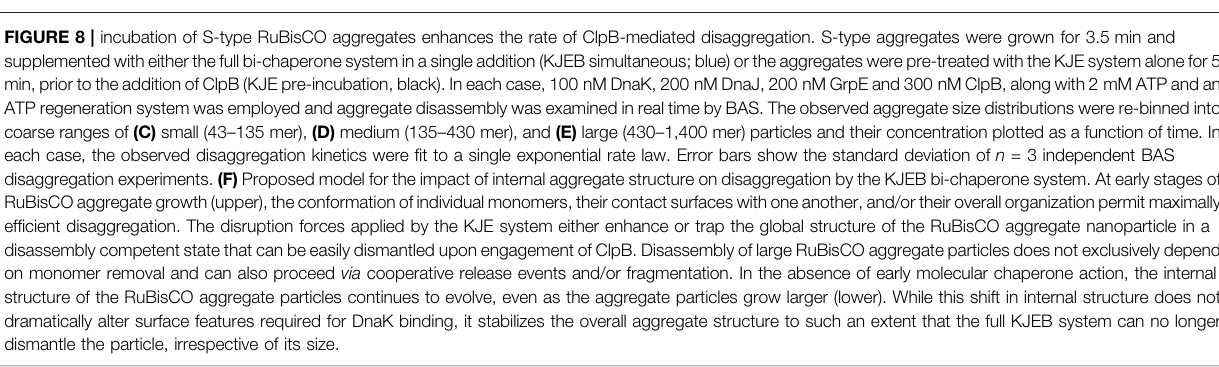
FIGURE 8 | incubation of S-type RuBisCO aggregates enhances the rate of ClpB-mediated disaggregation. S-type aggregates were grown for 3.5 min and supplementedwitheitherthefullbi-chaperonesysteminasingleaddition (KJEBsimultaneous;blue)ortheaggregateswerepre-treatedwiththeKJEsystemalonefor5 min, prior totheaddition ofClpB(KJE pre-incubation,black). Ineach case, 100 nM DnaK, 200 nM DnaJ,200 nM GrpE and 300 nM ClpB, alongwith2 mM ATPand an ATP regeneration system was employed and aggregate disassembly was examined in real time by BAS. The observed aggregate size distributions were re-binned